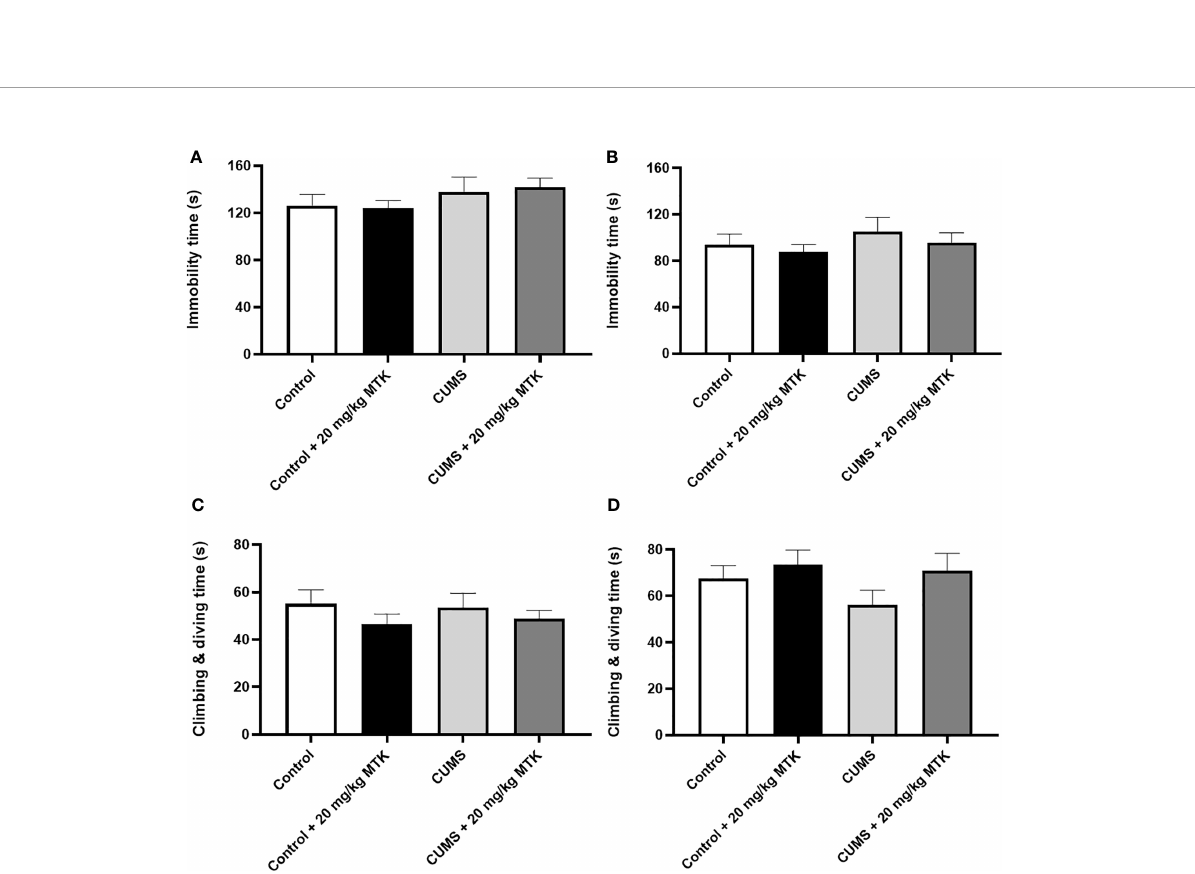
FIGURE 7 Effects of MTK on immobility and struggling time. Male (A, C) and female (B, D) rats were exposed to CUMS or control conditions for four weeks and then, while remaining under these conditions, were treated for two weeks with MTK 20 mg/kg or vehicle. Immobility time (A, B) and struggling (climbing/diving) time (C, D) were evaluated at the end of chronic MTK treatment. Each column is the mean ± SEM of 12 to 18 rats per group. Using one-way ANOVA (with Benjamini – Hochberg False Discovery Rate), followed by Student ’ s t-test for speci fi c group comparisons, no signi fi cant differences between the groups were observed.